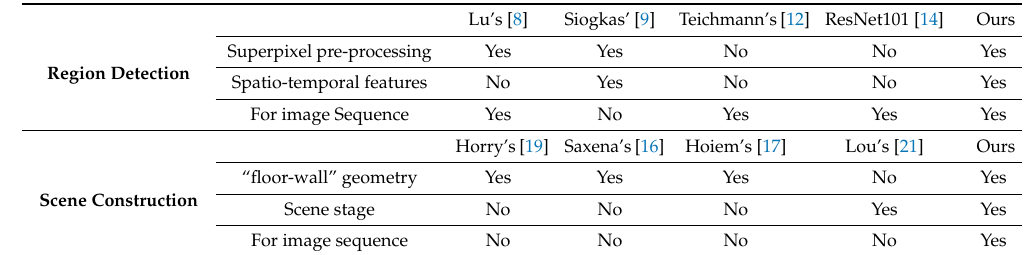
Table 1. Overview of the previous studies.